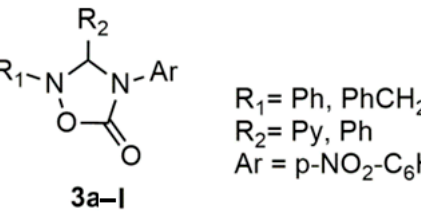
Figure 2. Stilbene-based p38 inhibitors characterized by a vicinal 4-fluorophenyl/4-pyridine motif.